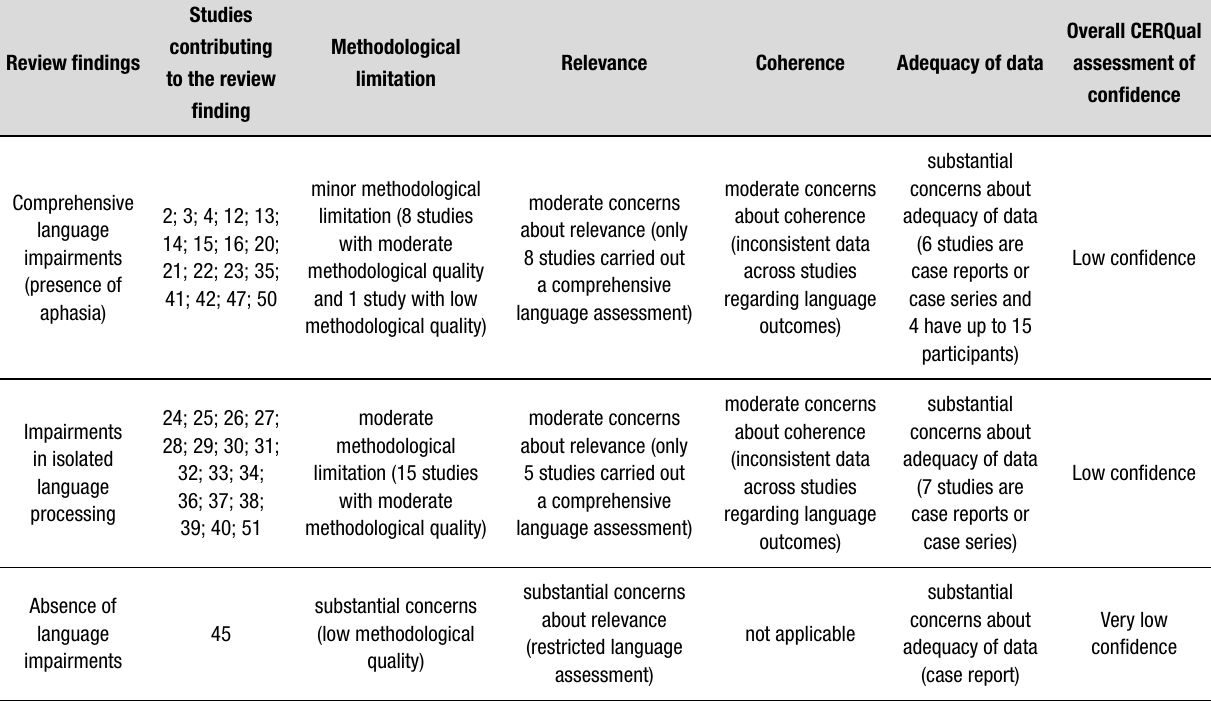
Table 3. Confidence in the Evidence from Reviews of Qualitative Research assessment of review